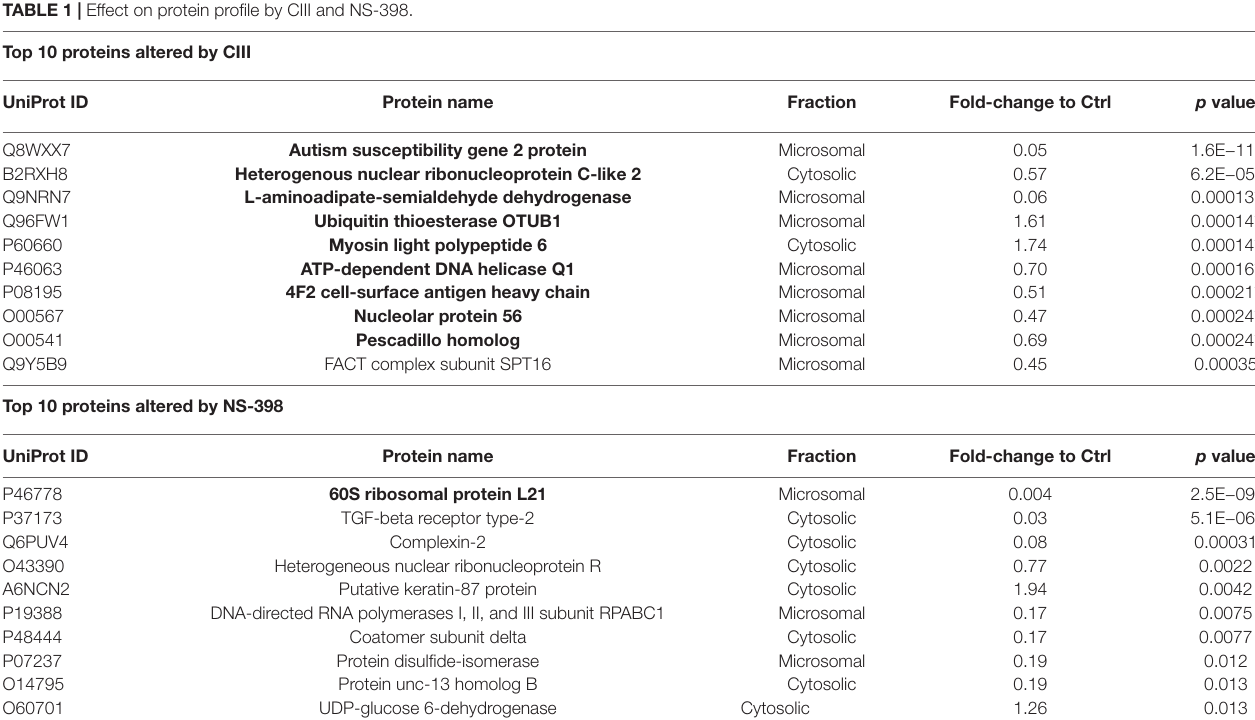
Table 1 . Performing Benjamin–Hochberg procedure to account for multiple testing resulted in nine proteins for CIII and two